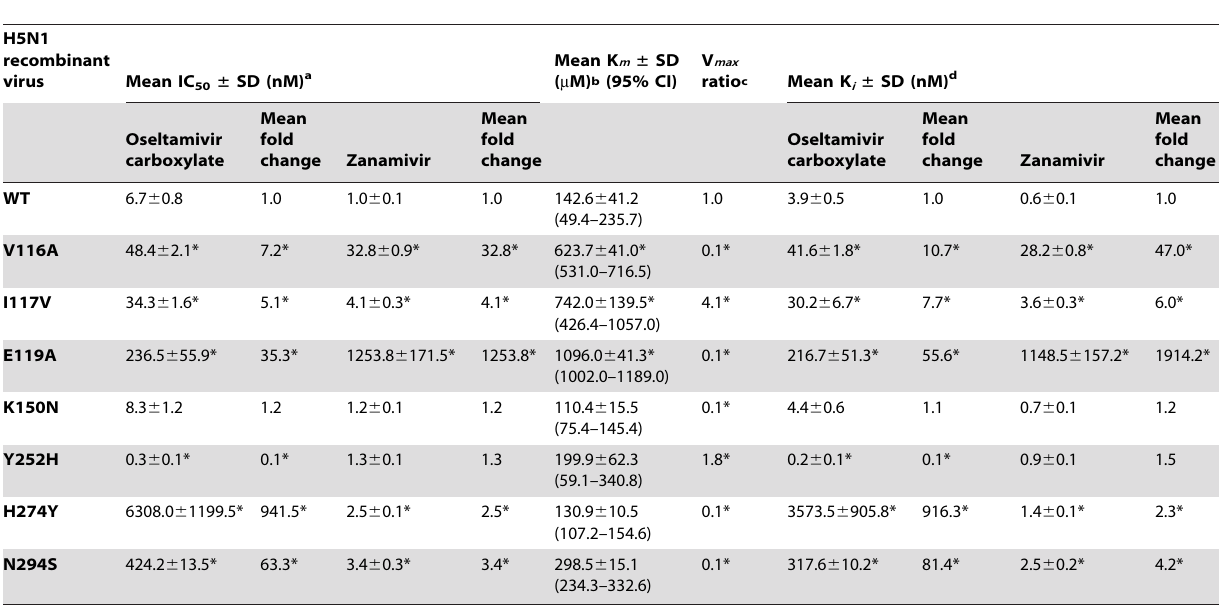
Table 2. Enzymatic Properties of the Neuraminidase of Recombinant H5N1 Influenza Viruses. H5N1